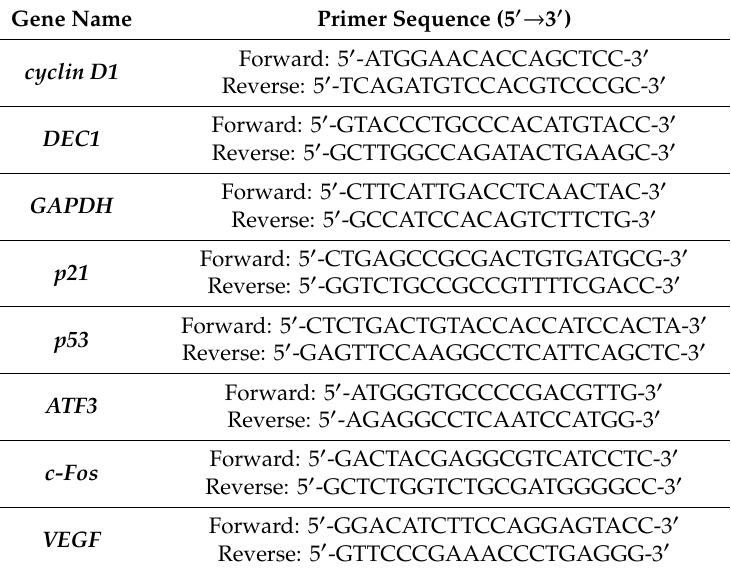
Table 1. PCR primers used in this